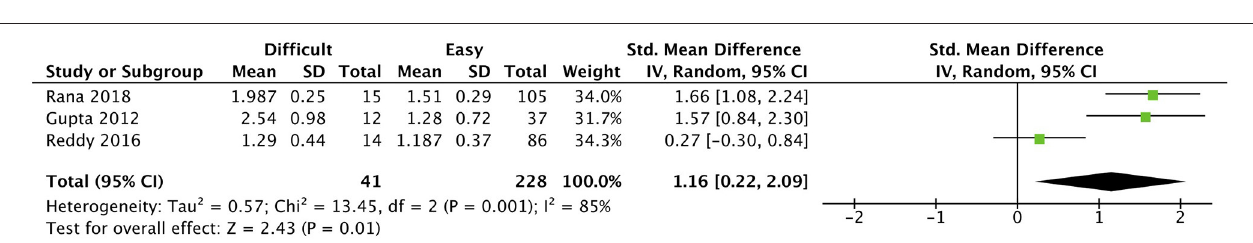
Hyomental Distance in Ramped to Neutral Position Ratio (HMDR1) Petrisor et al. (23) found that HMDR1 equal or inferior to 1.12 (Se: 75%, Sp: 76.2%) predicts a difficult